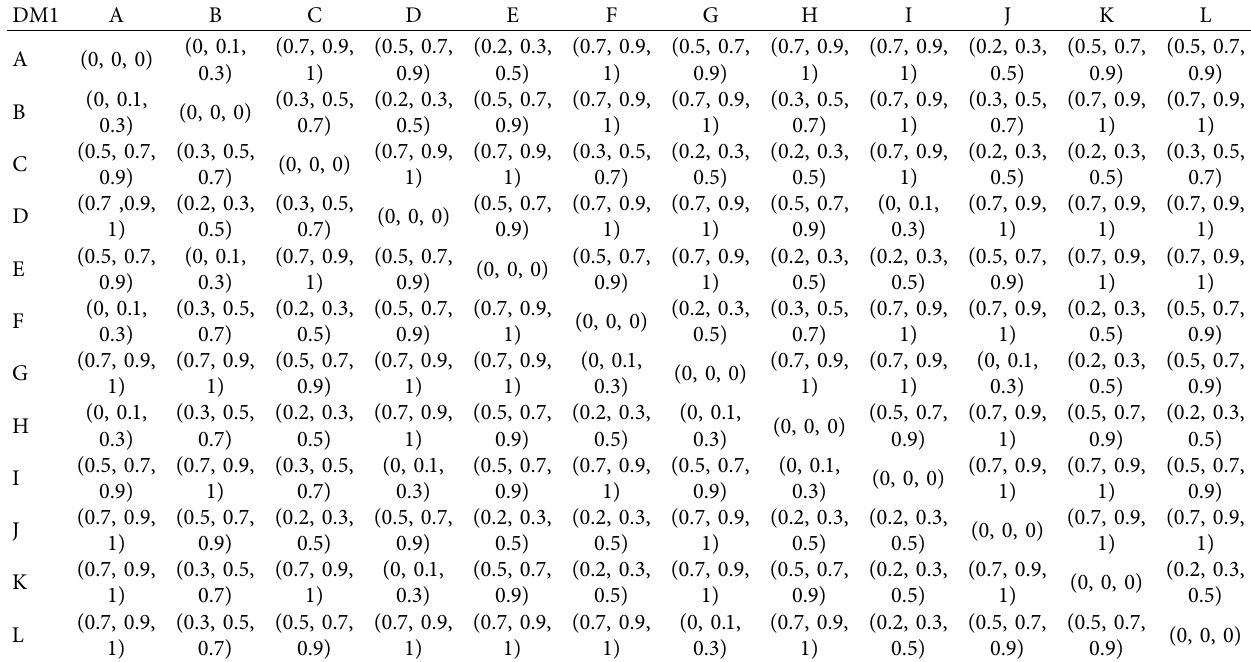
Table 8: The fuzzy direct relationship matrix 􏽥 Z .